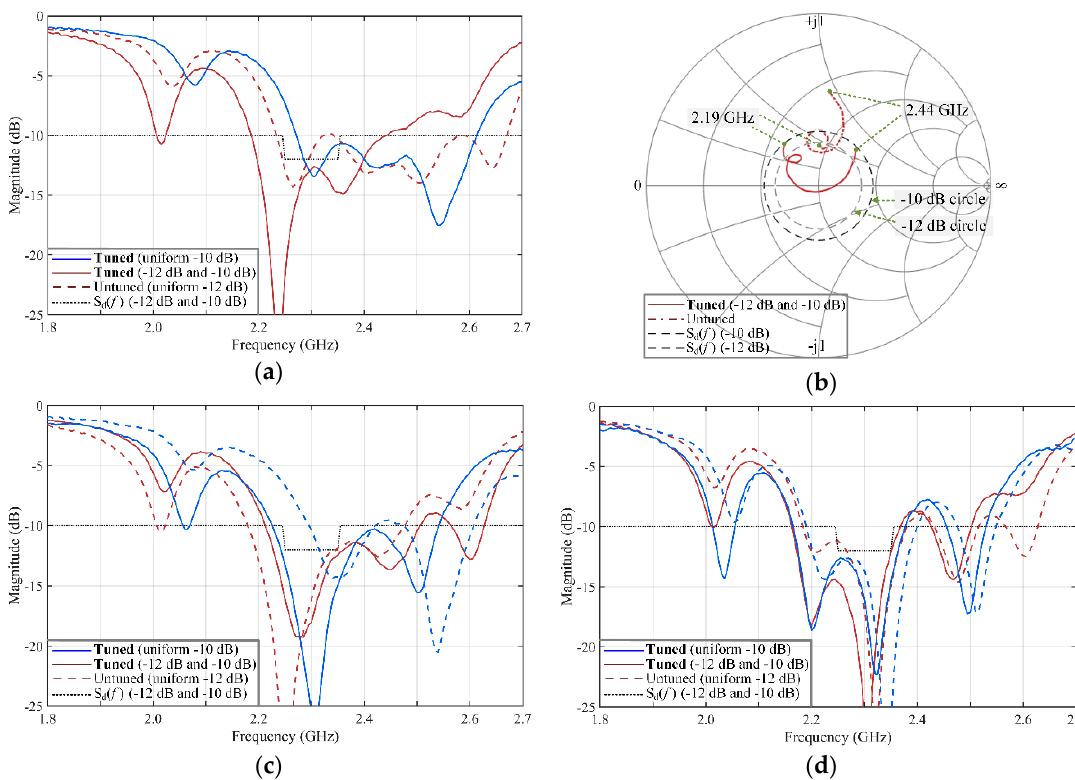
Figure 5. The blue and brown lines show return losses with gaps of ( a ) 60, ( c ) 40, and ( d ) 20 mm. Dark solid lines show automatically tuned return losses, and dashed lines show return loss results before tuning. Dotted lines show the − 10 and − 12 dB condition. The Smith chart for the non-uniform tuned results with a gap of 60 mm is shown in ( b ).